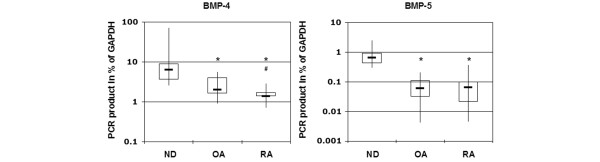
Expression of BMP-4 and BMP-5 in synovial tissues detected by semiquantitative PCR. Results are presented as percentage of GAPDH expression on a logarithmic scale with maximum, minimum, quartiles and median. Where indicated, there were significant differences from normal tissues (asterisk) or osteoarthritis (OA) (hash sign) (p < 0.05, Mann–Whitney). Rheumatoid arthritis (RA) versus normal donors (ND): bone morphogenetic protein (BMP)-4, p = 0.0005; BMP-5, p = 0.0016. OA versus ND: BMP-4, p = 0.0143; BMP-5, p = 0.0011. RA versus OA: BMP-4, p = 0.0180; BMP-5, p = 0.9215. GAPDH, glyceraldehyde-3-phosphate dehydrogenase.